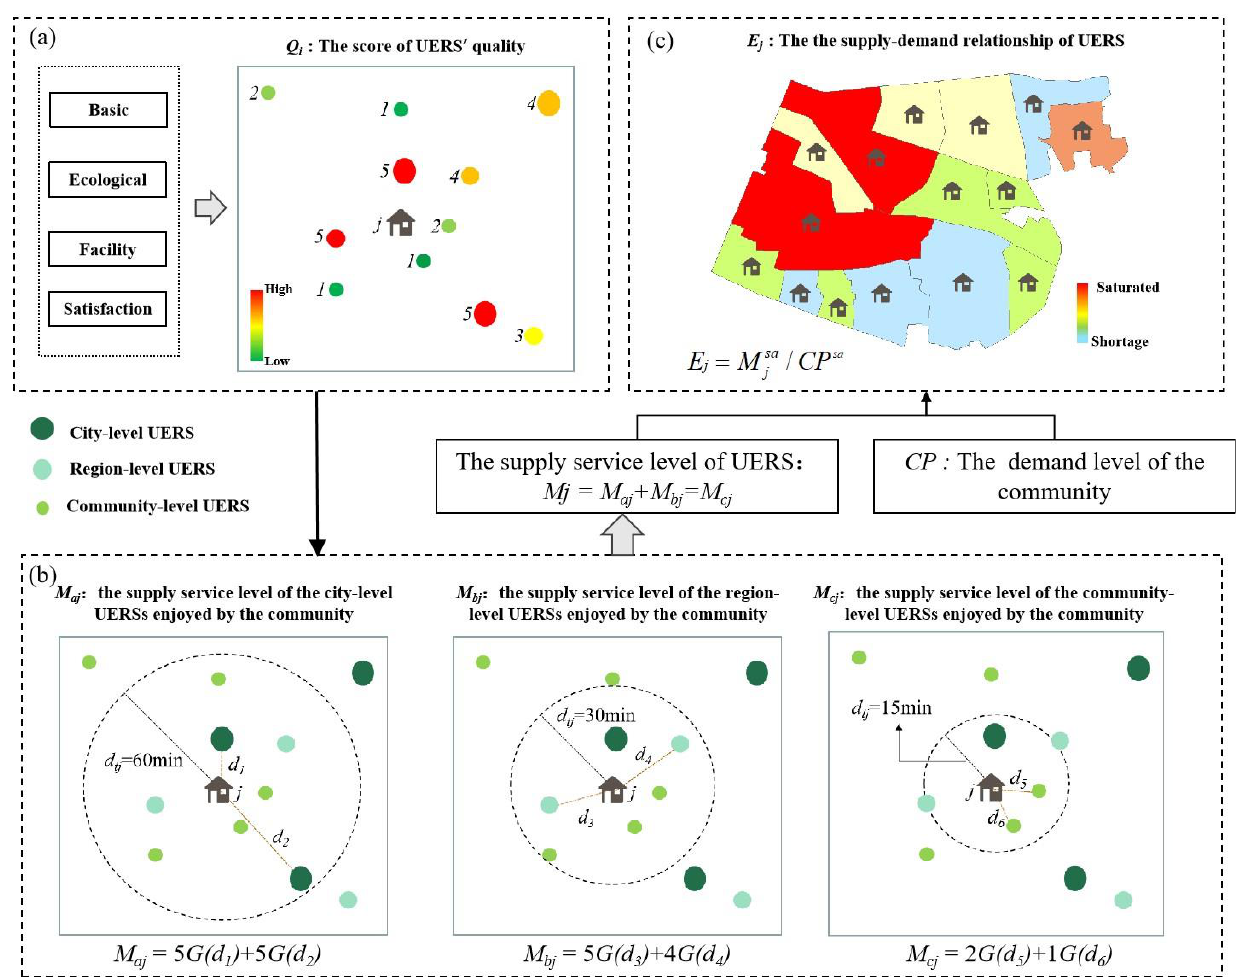
Figure 3. Quantification of the quality of UERS ( a ) and the supply level of UERS ( b ), and quantification of the supply – demand matching relationship of UERS ( c ).